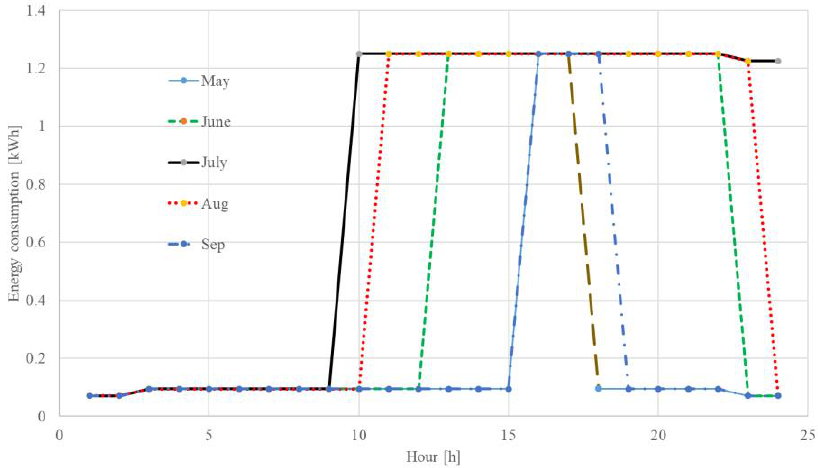
Figure 3. Hybrid system operation daily energy consumption.